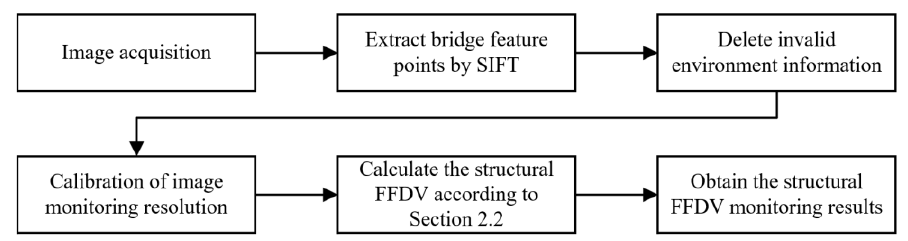
Figure 24. Steps of structural full-field displacement monitoring.